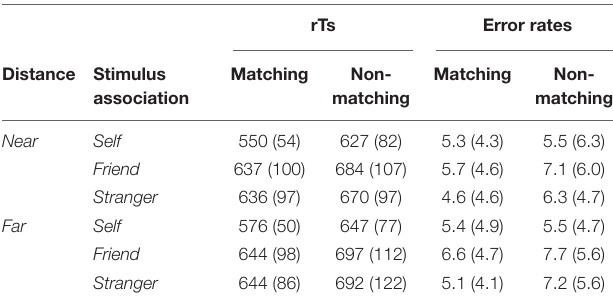
TABLE 1 | RTs (in ms) and error rates (in %) of Experiment 1 as a function of distance, stimulus association, and match (standard deviations in